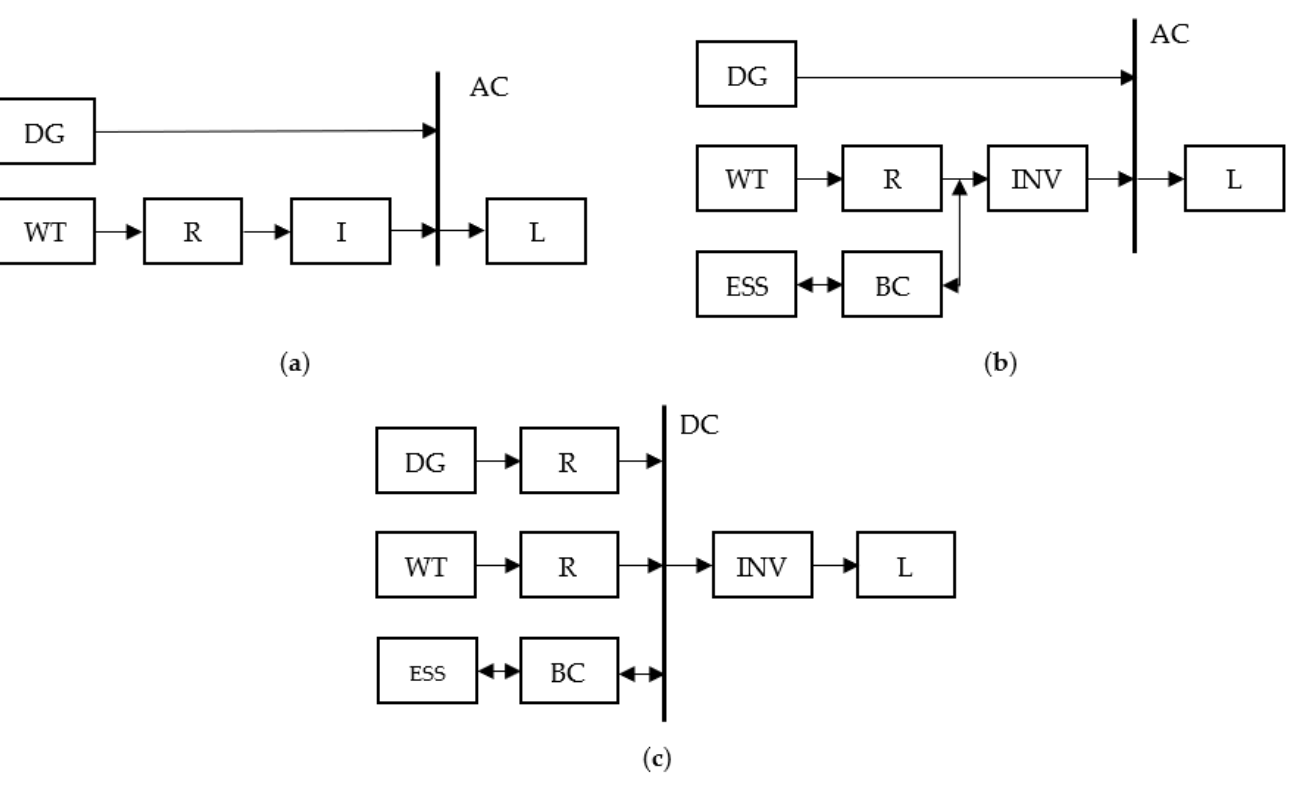
Figure 3. WDHS block diagram: ( a ) without ESS on the AC bus; ( b ) with ESS on the AC bus; ( c ) with ESS on the DC bus. DG—diesel generator; R—rectifier; WT—wind turbine; INV—inverter; L—load; ESS—energy storage system; BC—bidirectional converter.